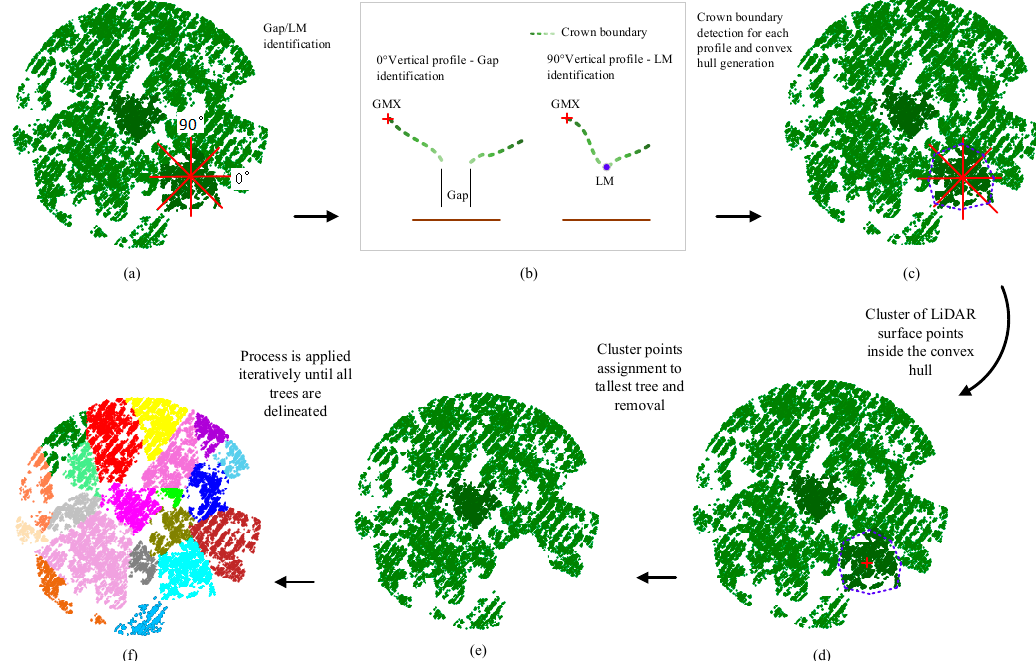
Figure 4. Illustration of the five routines within the DSM-based tree segmentation approach.